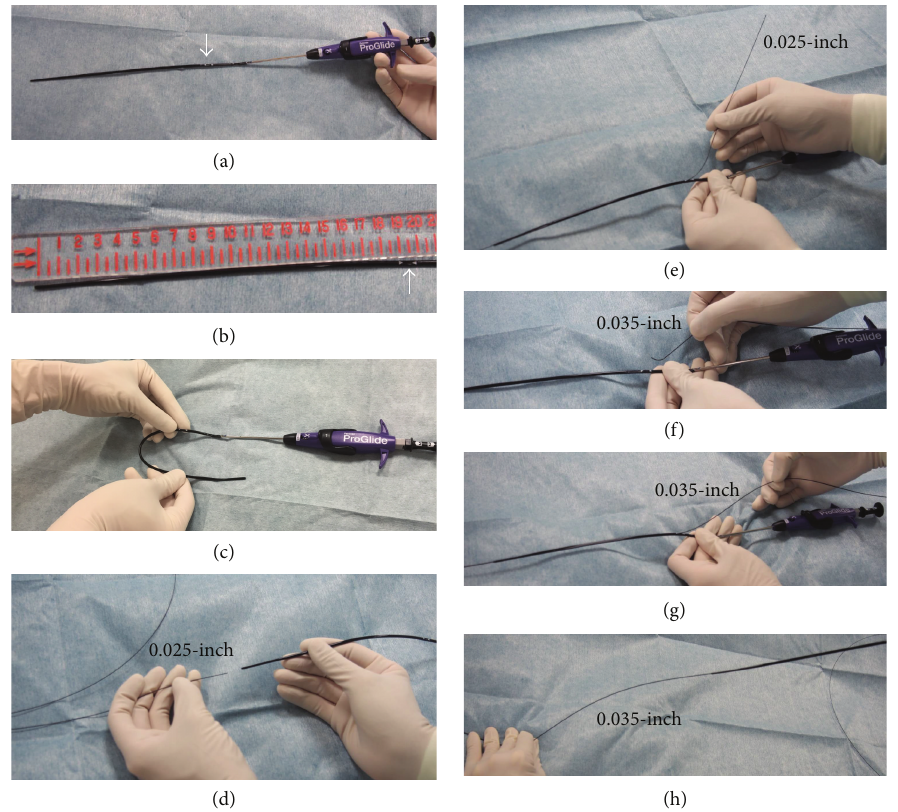
Figure 4: The ex vivo procedure for guidewire exchange. (a) Perclose ProGlide (Abbott vascular, Abbott Park, Illinois, USA). A white arrow shows the position of the exit port. (b) The length between the tip and exit port (white arrow) of the Perclose ProGlide is approximately 19.5 cm. (c) The rubber part of the Perclose ProGlide is flexible. (d) A 0.025-inch guidewire is inserted via the tip of the Perclose ProGlide. (e) A 0.025-inch guidewire is pulled out from the exit port of the Perclose ProGlide. (f) A 0.035-inch guidewire is inserted via the exit port of the Perclose ProGlide. (g) A 0.035-inch guidewire is advanced and pulled out from the tip of the Perclose ProGlide. (h) The Perclose ProGlide is pulled out, and the 0.035-inch guidewire is left in place. This completes the switch from a 0.025-inch guidewire to a 0.035-inch